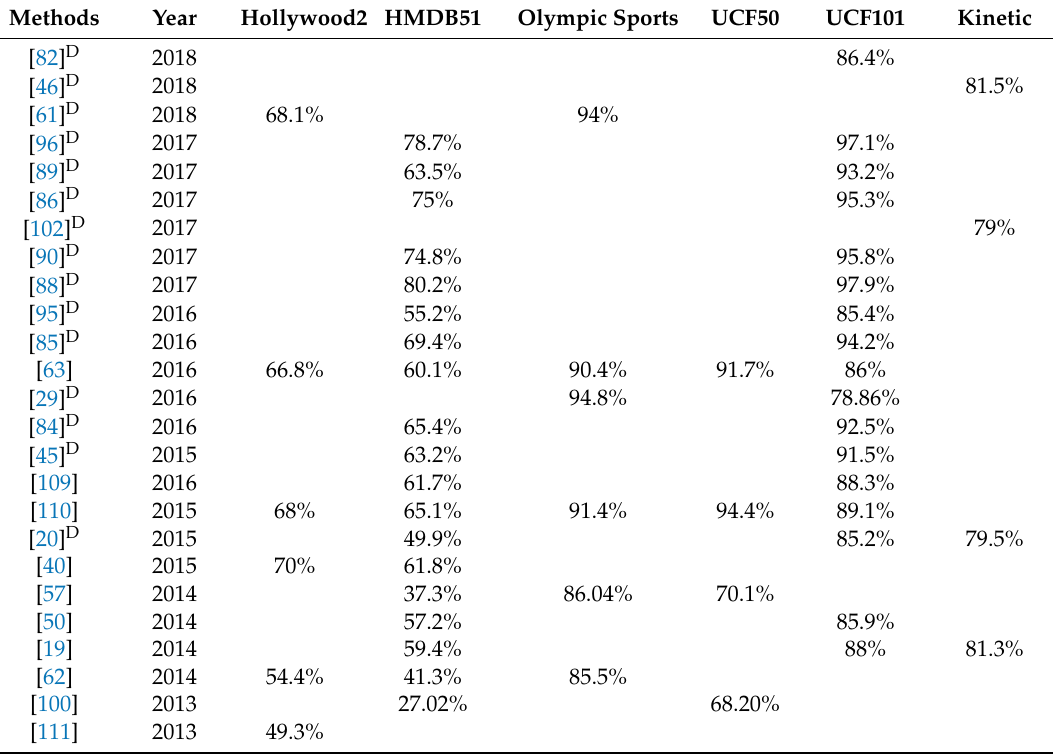
Table 2. Recognition accuracies of methods on RGB datasets. The superscript D indicates a deep learning-based